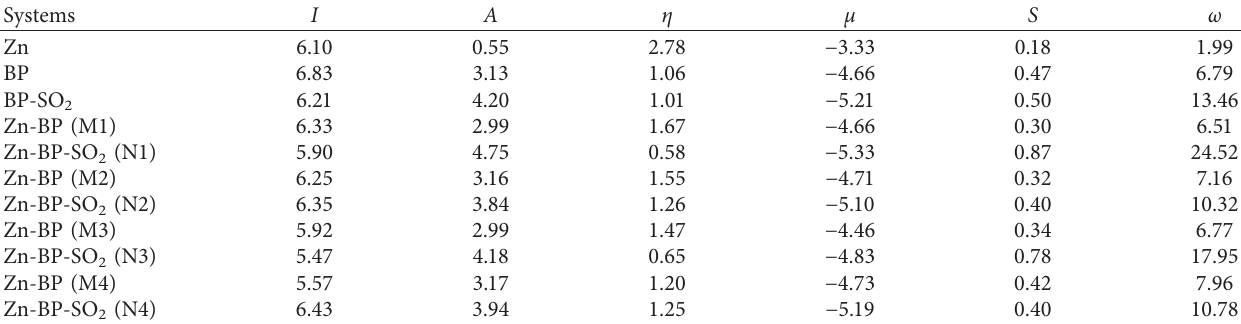
Table 3: The ionization potential ( I ), electron affinity ( A ), chemical hardness ( η ), chemical potential ( μ ), softness ( S ), and electrophilicity ( ω ) for different systems.